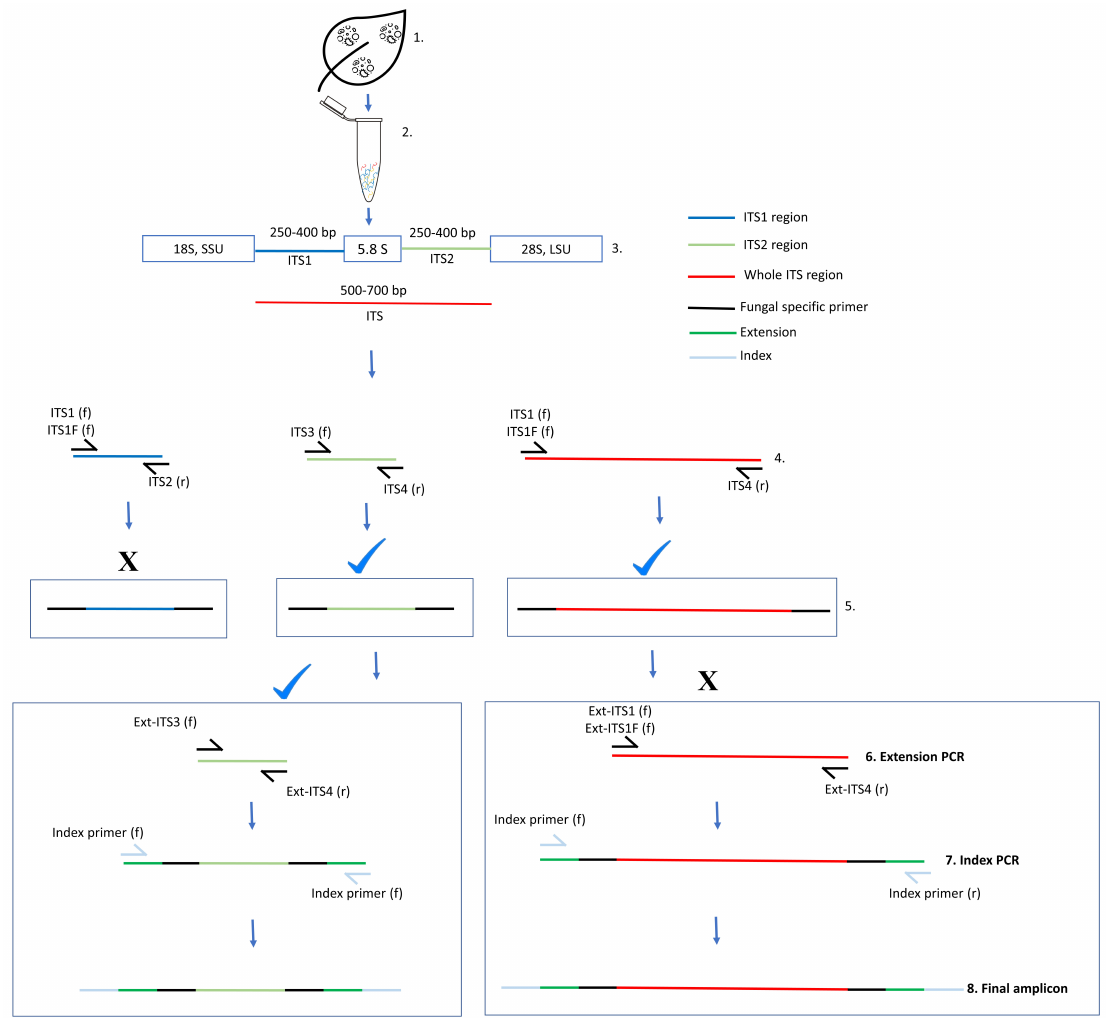
Figure 2. Schematic diagram showing the sequences of primers and general sequential steps